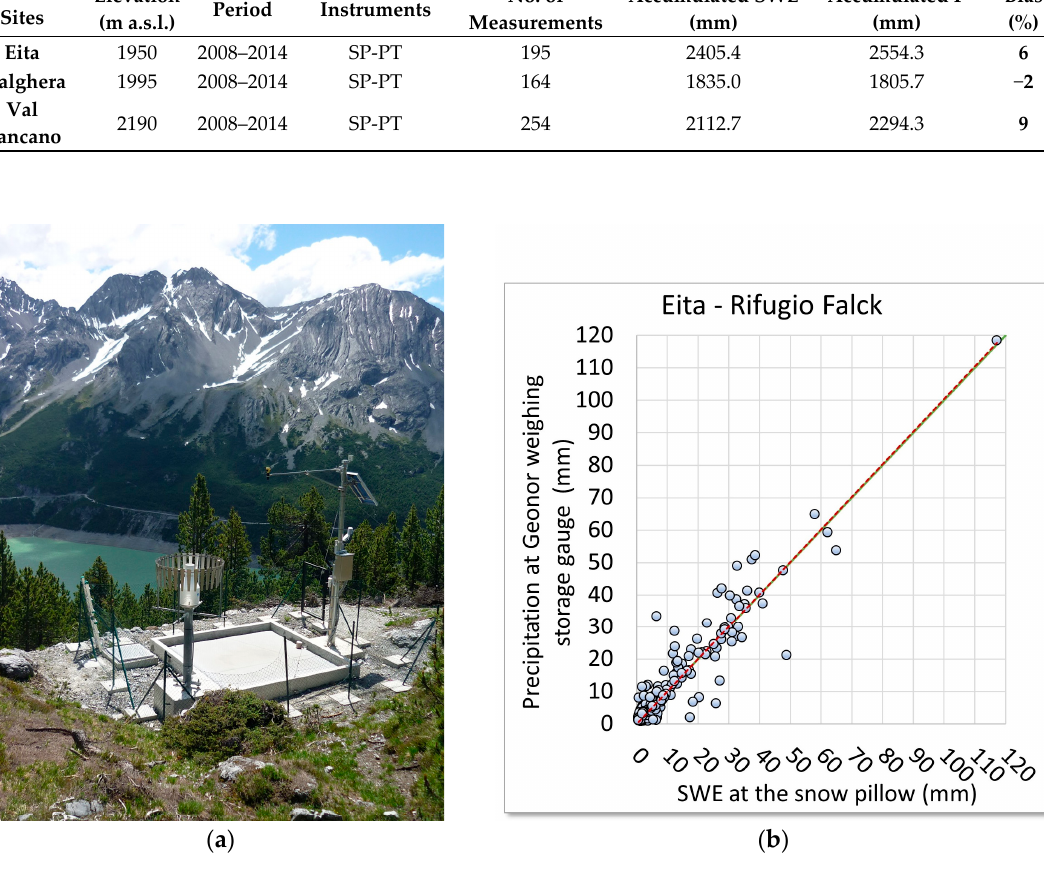
Figure 5. ( a ) Val Cancano monitoring site managed by A2A equipped with Geonor T200B weighing storage gauge with an Alter-type wind-shield and snow pillow; and ( b ) a comparison of daily precipitation measurements: melted snow measured by the Geonor weighing storage gauge with an Alter-type wind-shield versus SWE of fresh fallen snow measured by snow pillows, for the period